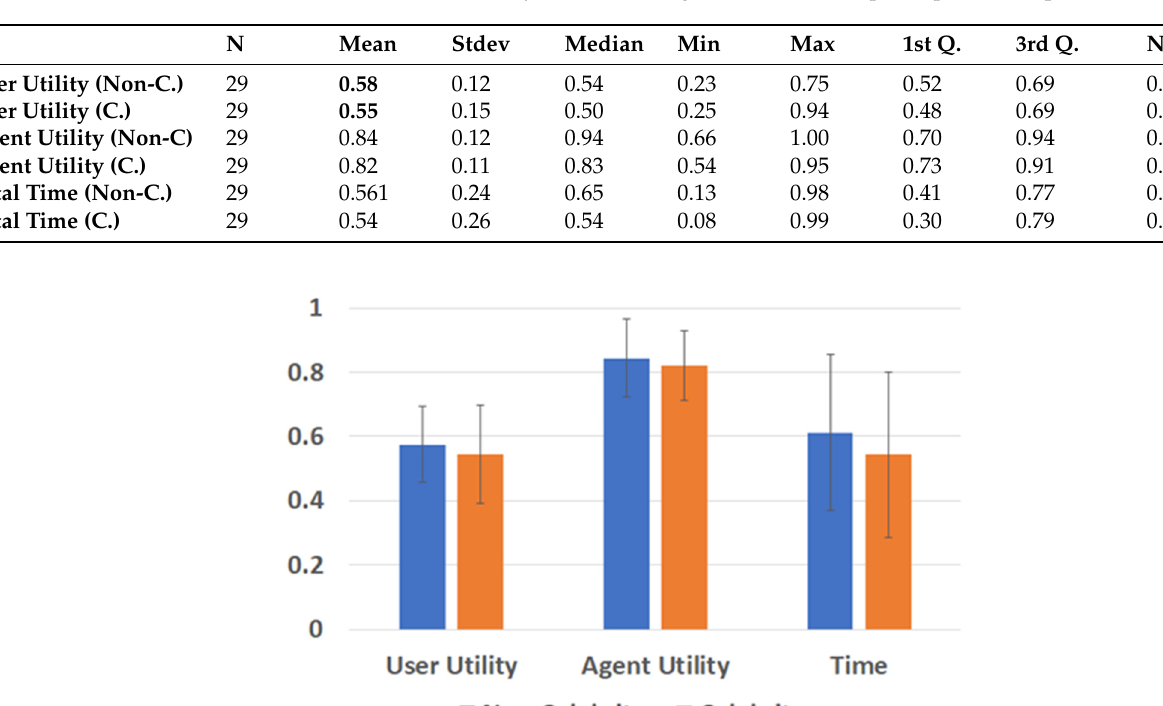
Figure 8. Acceptance Rates for H2 Related Data.